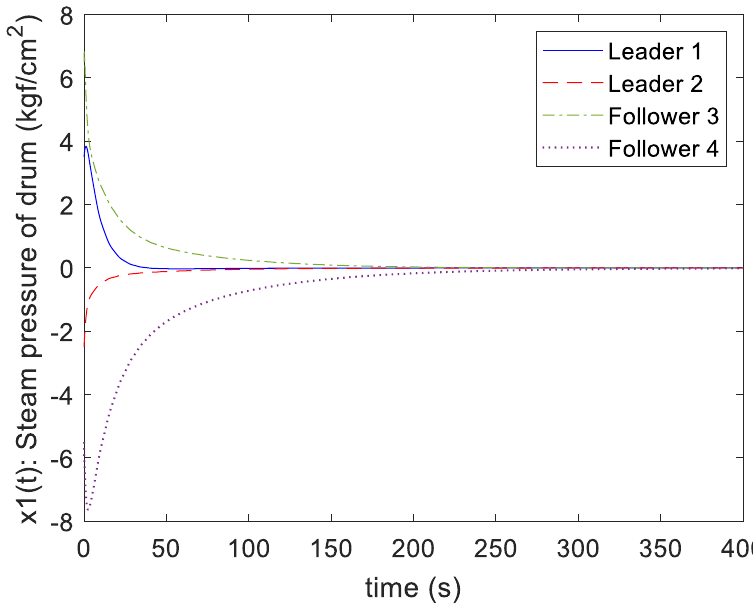
Figure 5. Responses of state x 1 ( t ) with IT-2 fuzzy control.